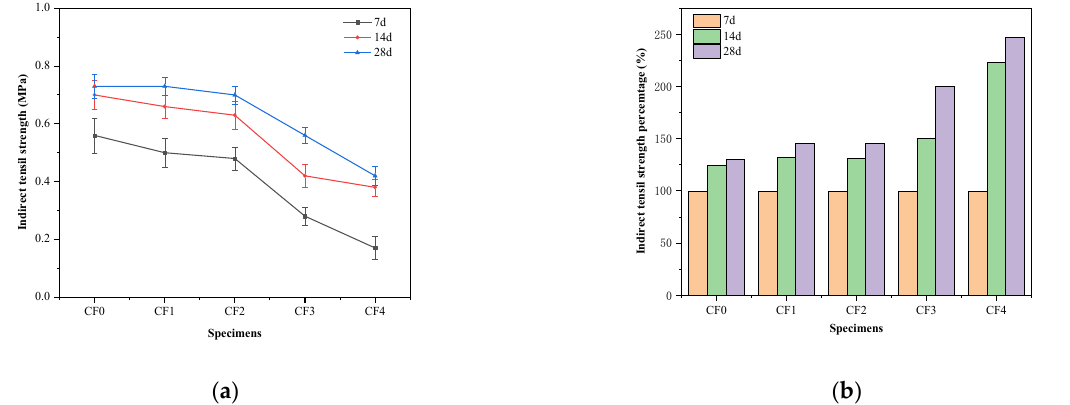
Figure 3. ( a ) ITS of CSM with 100% RMA under different fly ash replacement rates and ( b ) The ratio of ITS at different ages to the 7 d strength.